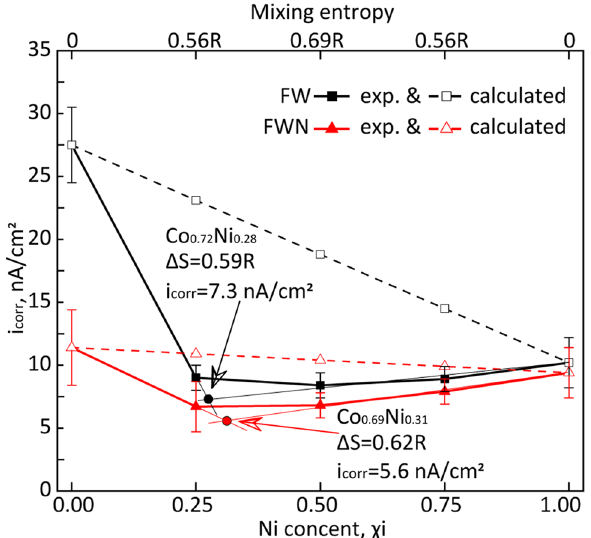
Figure 11. Corrosion current density, i corr, results as a function of Ni content and respective mixing entropy values of the Co- and Ni-containing NPs exposed in FW and FWN solutions. The experimental data is presented as solid lines and the calculated data as dashed lines (via the rule of